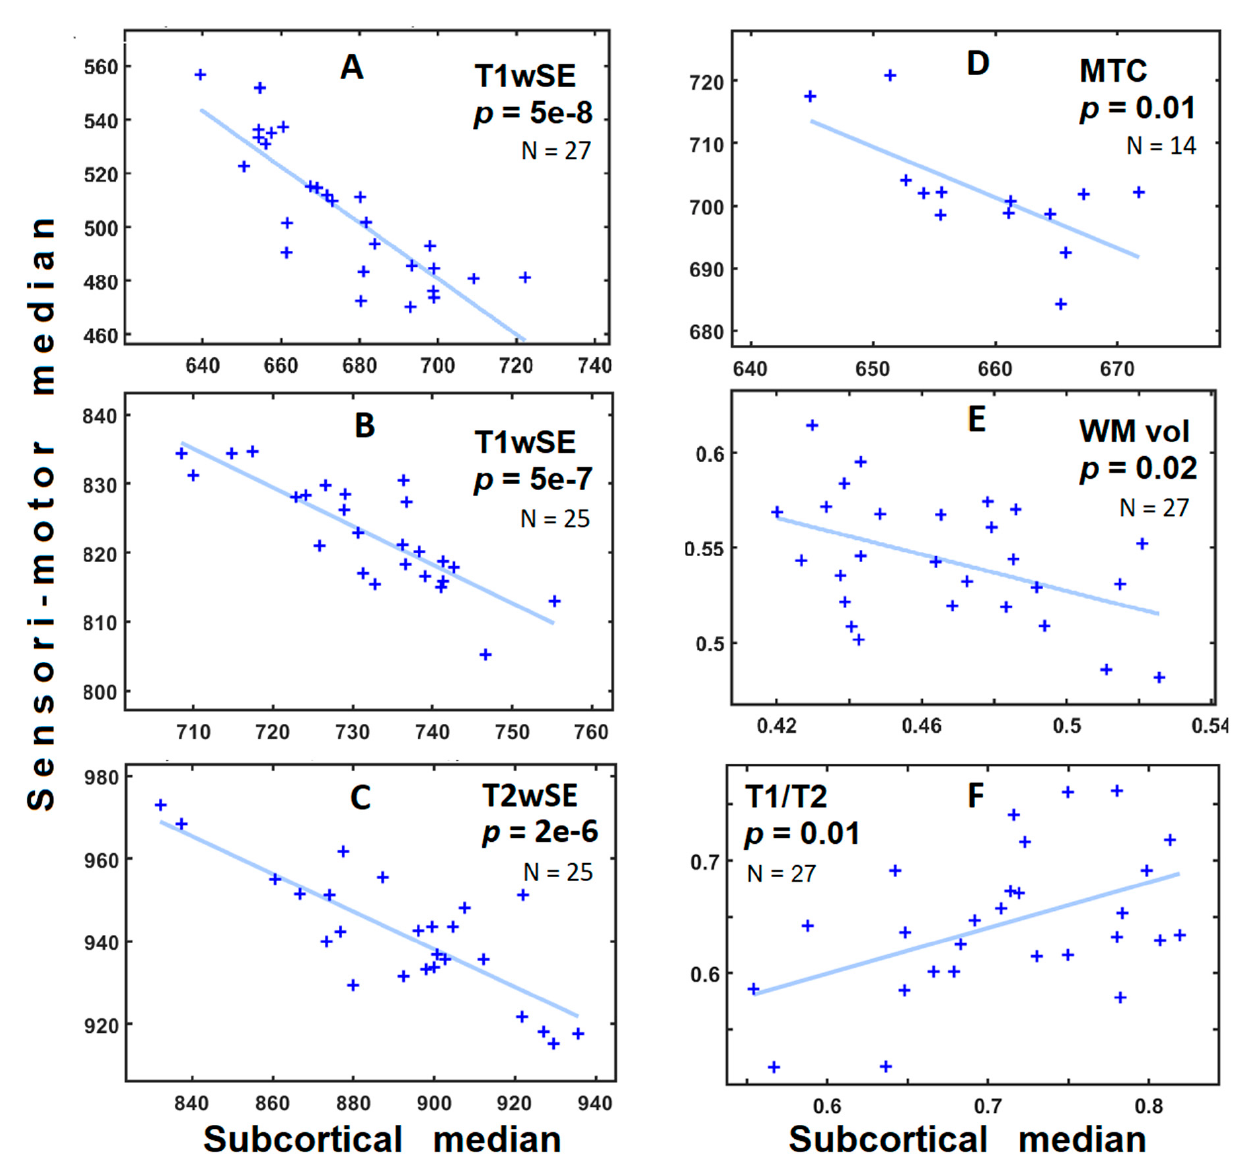
Figure 2. Scatter plots for controls (HC) from 6 image-sets from three cohorts involving five MRI modalities (T1wSE, T2wSE, MTC, WM volume and T1/T2). Each ‘+’ is located by the median MRI value in sensorimotor (y coordinate) and subcortical (x coordinate) regions for an individual subject. Cohort membership is 2016 ( A , E , F ); 2012 ( D ) and 2006 ( B , C ). Blue lines show the linear fit of the HC values. p is the probability that the observed HC distribution occurred by chance, and N is the number of HC subjects. HC negative correlations are seen for all image-sets except F. In ( A , B , C , D ) the units derive from the scanner. In ( E ), units are WM volume fraction, in ( F ) units are a ratio. The strongest correlations were from T1wSE ( A , B ) with N = 27 and N = 25, respectively, and T2wSE ( C ) with N = 25. The MTC reciprocal correlation was significant despite its low (N = 14) sample size.